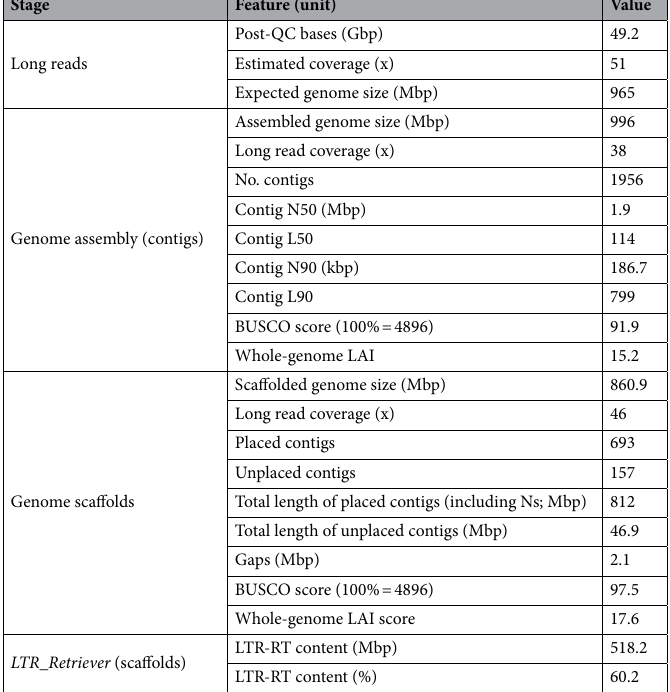
Table 2. Genome assembly statistics for O. australiensis keep